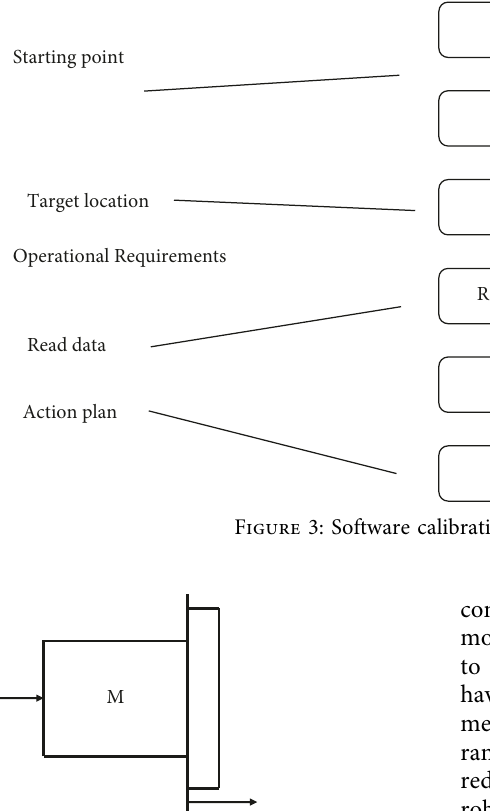
Figure 4: Stress relationship between each node of the inspection